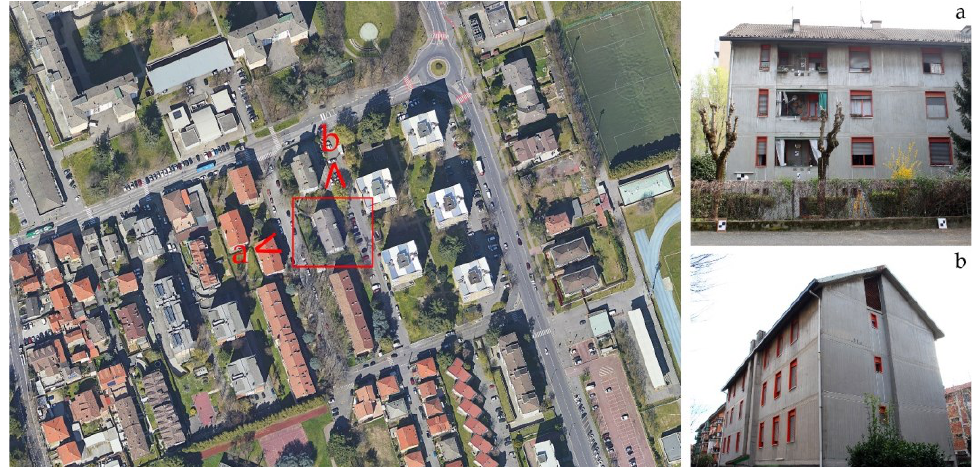
Figure 2. Case study location, in the northern suburban area of Cinisello Balsamo, Milano, IT. Source: Google Earth. Main façades of the Italian demo building ( a , b ). Google Earth. Main façades of the Italian demo building ( a , b